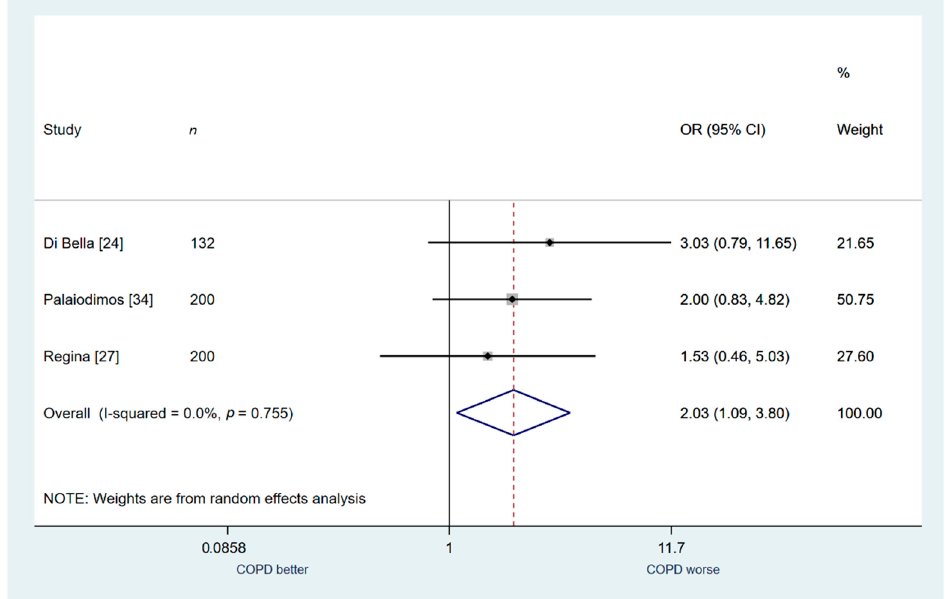
Figure 6. COPD vs. no COPD for the outcome of intubation.